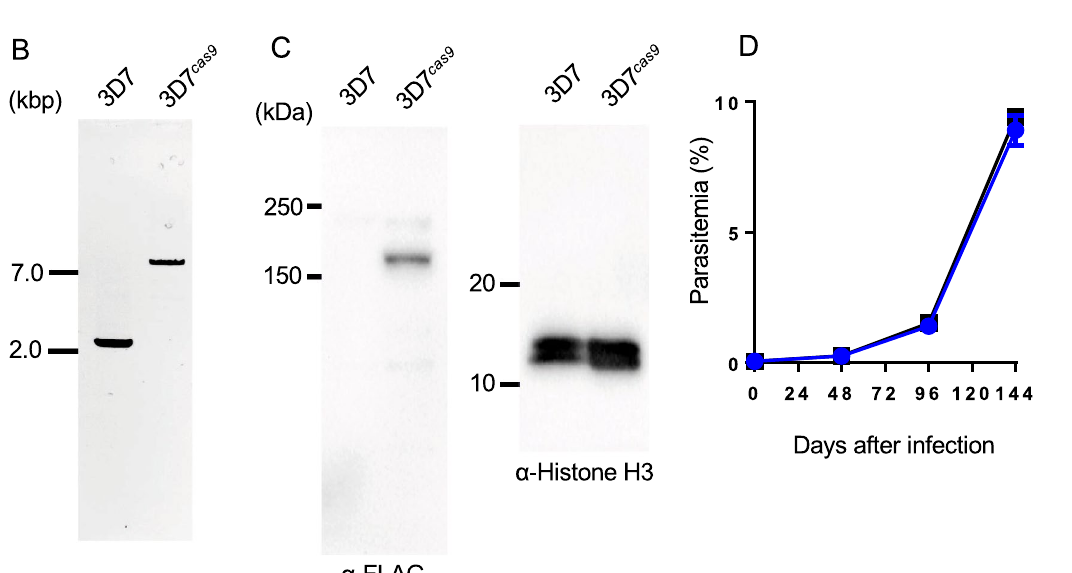
SNPs (Supplementary data 4). Therefore, we concluded based on those results that the constitutive expression of Cas9 did not cause unexpected mutations in the parasite genome.